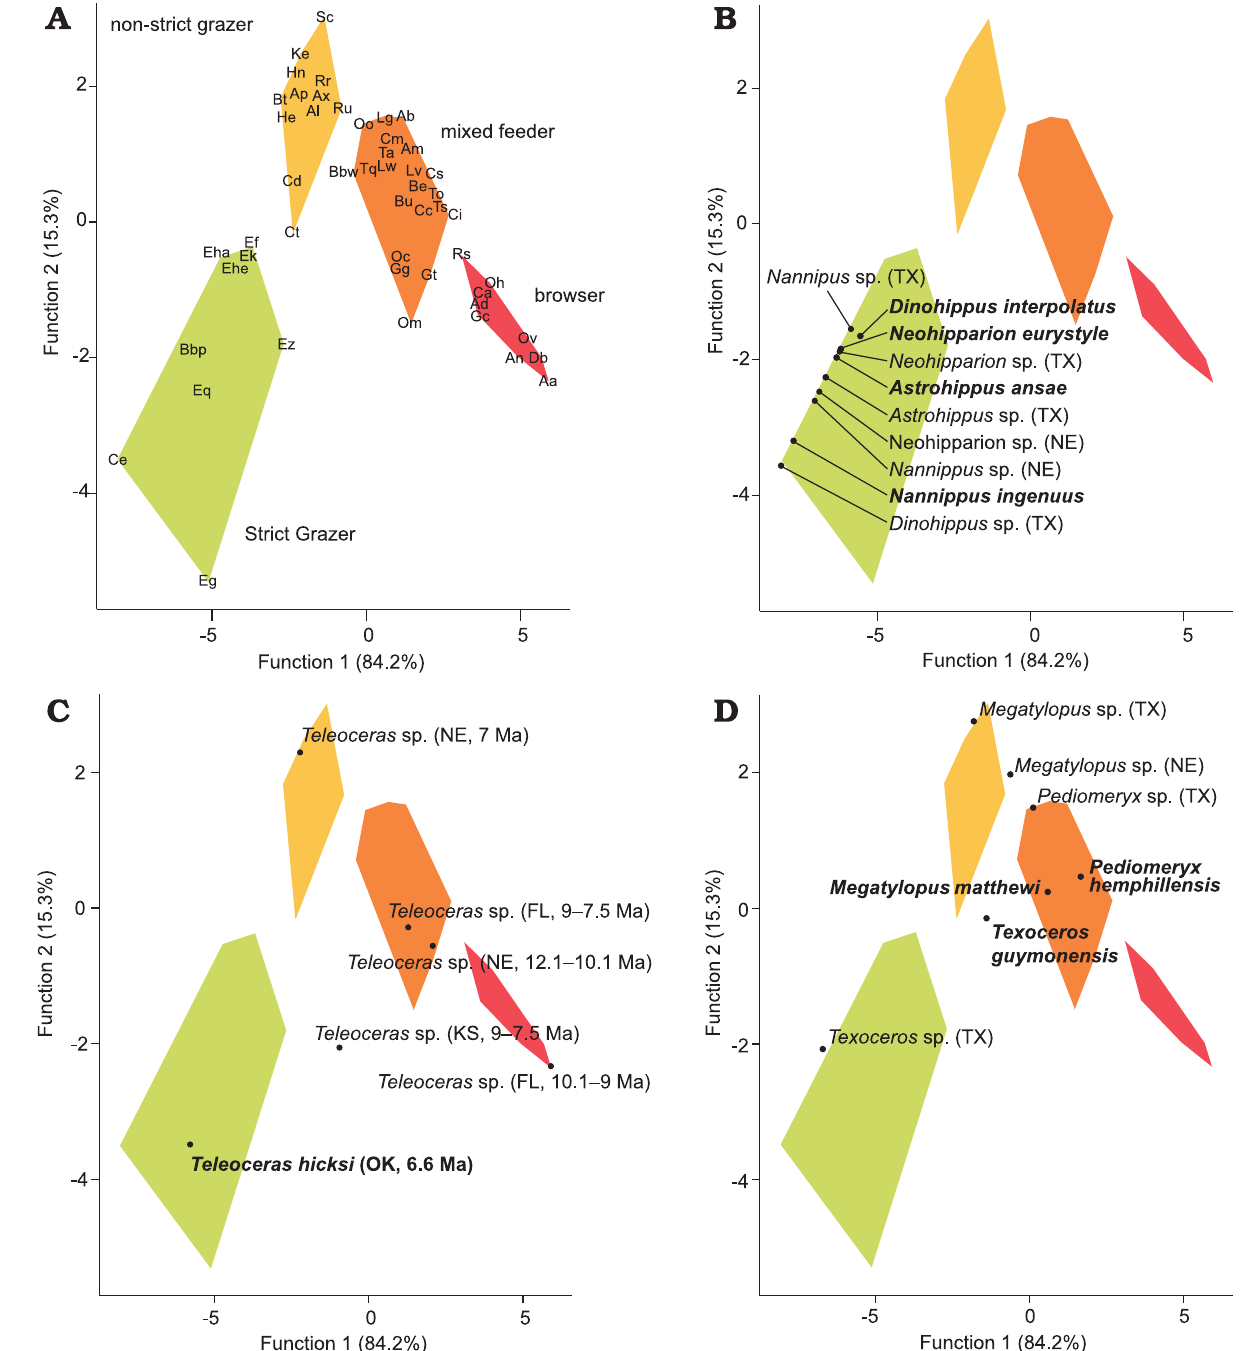
Fig. 3. Mesowear discriminant function analysis for Optima Local Fauna (Miocene, late Hemphillian, Oklahoma, USA) artiodactyls and perissodactyls com­ pared to closely­related taxa from other Miocene sites from North America and modern taxa (see Material and methods). A . Modern taxa (data from Fortelius and Solounias 2000; Rivals et al. 2007; Fraser and Theodor 2013; Schulz and Kaiser 2013; Taylor et al. 2014; Jones and DeSantis 2017; Mihlbachler et al. 2018). B . Equidae. C . Teleoceras . D . Artiodactyla. Abbreviations: Aa, Alces alces ; Ab, Alcelaphus buselaphus ; Ad, Antidorcas marsupialis ; Al, Alcelaphus lichtensteinii ; Am, Aepyceros melampus ; An, Antilocapra americana ; Ap, Axis porcinus ; Ax, Axis axis ; Bbp, Plains bison Bison bison ; Bbw, Wood bison Bison bison ; Be, Boocercus euryceros ; Bt, Boselaphus tragocamelus ; Bu, Budorcas taxicolor ; Ca, Capreolus capreolus ; Cc, Cervus canadensis ; Cd, Cervus duvauceli ; Ce, Ceratotherium simum ; Ci, Capra ibex ; Cm, Camelus dromedarius ; Cs, Capricornis sumatraensis ; Ct, Connochaetes taurinus ; Db, Diceros bicornis ; Ef, Equus ferus przewalski ; Eg, Equus grevyi ; Eha, Equus hartmannae ; Ehe, Equus hemionus ; Ek, Equus kiang ; Eq, Equus quagga ; Ez, Equus zebra ; Gc, Giraffa camelopardalis ; Gg, Gazella granti ; Gt, Gazella thomsoni ; He, Hippotragus equinus ; Hn, Hippotragus niger ; Ke, Kobus ellipsiprym­ nus ; Lg, Lama glama ; Lv, Lama vicugna ; Lw, Litocranius walleri ; Oc, Ovis canadensis ; Oh, Odocoileus hemionus ; Om, Ovibos moschatus ; Oo, Ourebia ourebi ; Ov, Odocoileus virginianus ; Rr, Redunca redunca ; Rs, Rhinoceros sondaicus ; Ru, Rhinoceros unicornis ; Sc, Syncerus caffer ; Ta, Tragelaphus angasi ; To, Taurotragus oryx ; Tq, Tetracerus quadricornis ; Ts, Tragelaphus scriptus ; FL, Florida; KS, Kansas; NE, Nebraska; TX,